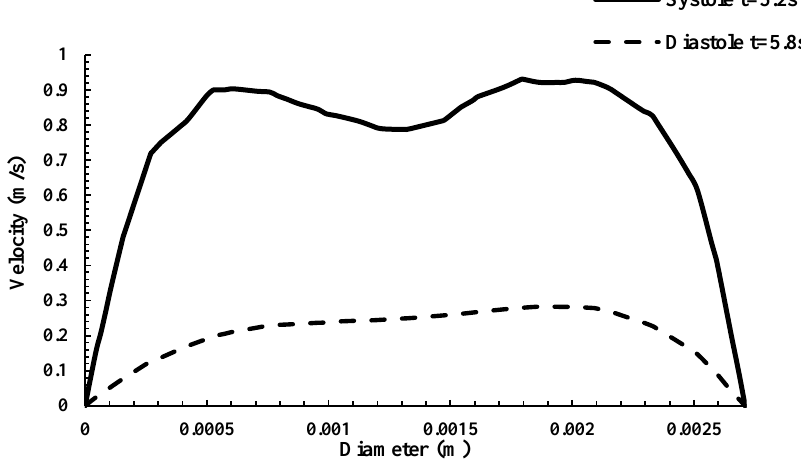
Figure 3. Velocity profiles at the cerebral artery branch contour segment at systole and diastole.